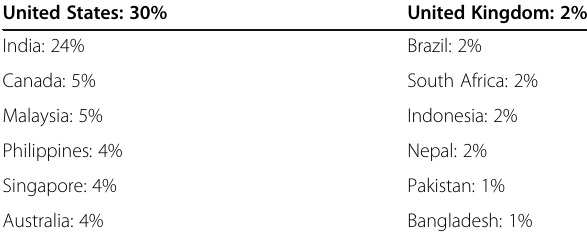
Table 2 Countries with Highest Participation